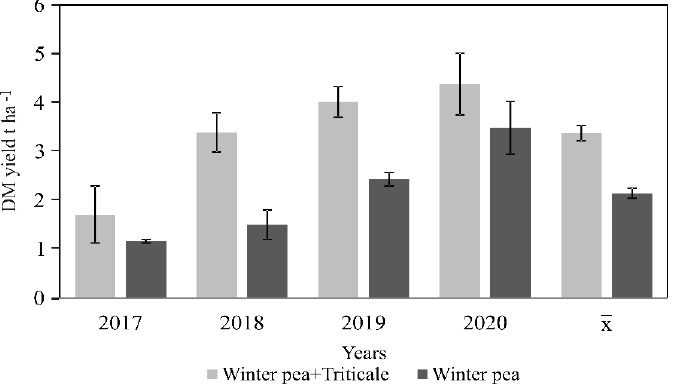
Figure 3. Dry matter yield of different type of CC − winter pea + Triticale (PT) and winter pea (P). Vertical bars on columns represent standard error (SE) of the mean.